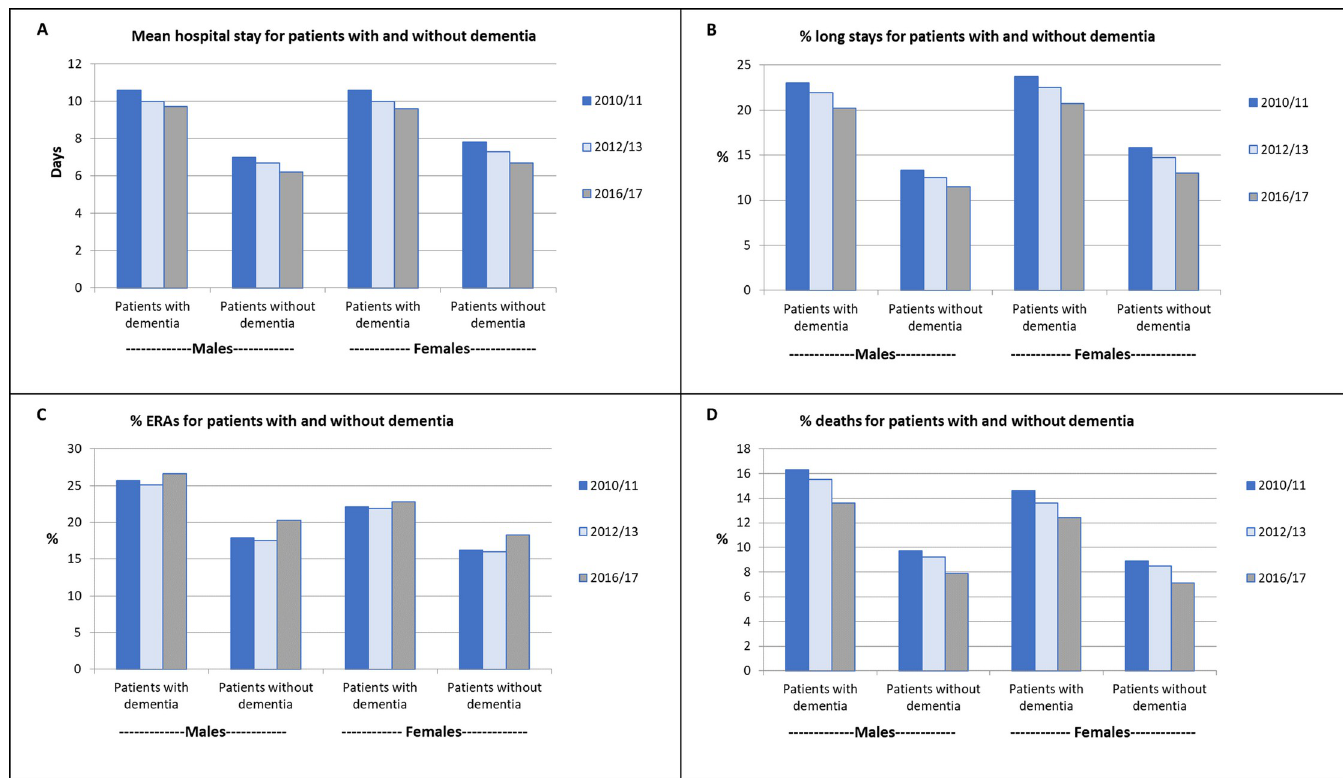
Fig 1. Unadjusted hospital outcomes for patients with and without